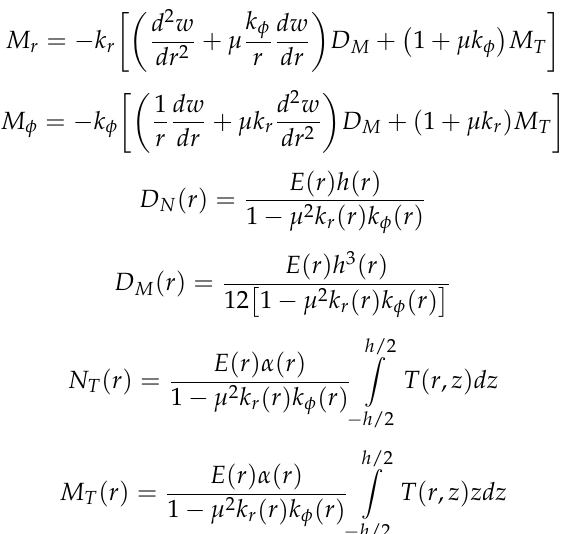
Figure 12. IS acceleration electrode additional deflection (∆w(0)) as a function of initially designed deflection (w 0 (0)) at different levels of temperature drop along AE radius.